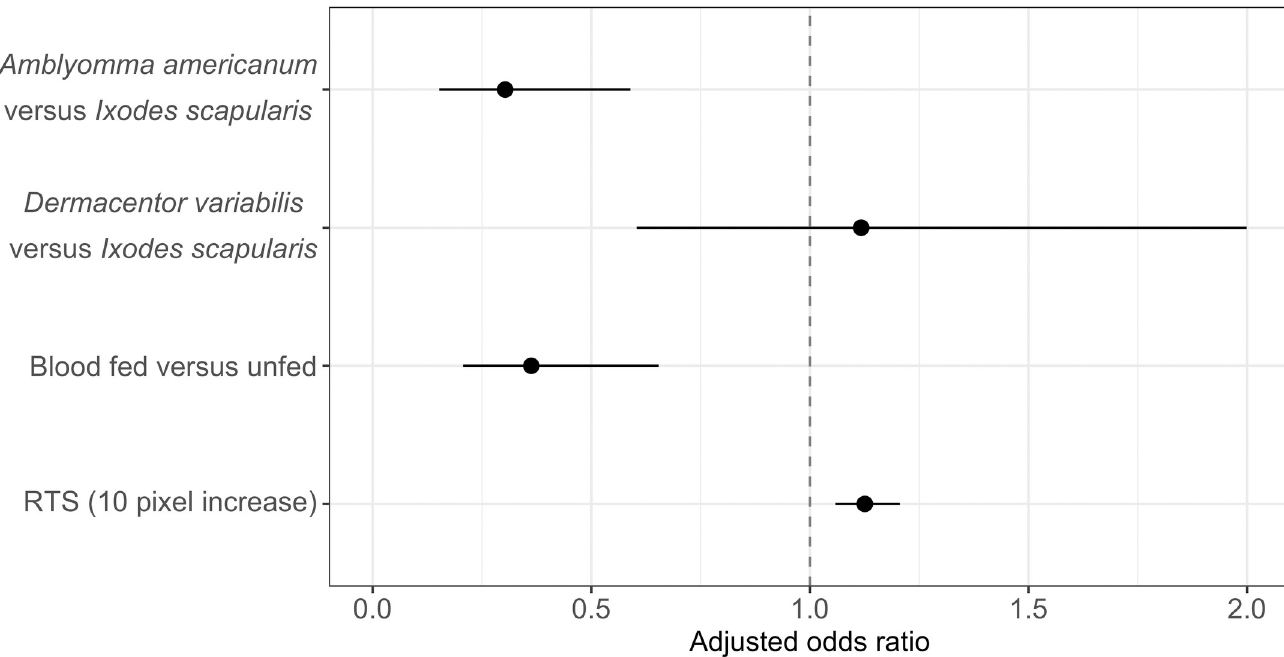
Fig 9. The adjusted odds ratios for correct TickIDNet predictions based on tick characteristics and relative tick size (RTS). Point estimate represents the adjusted odds ratio (aOR) and error bars the 95% confidence interval. The vertical line at aOR = 1 represents equal odds.